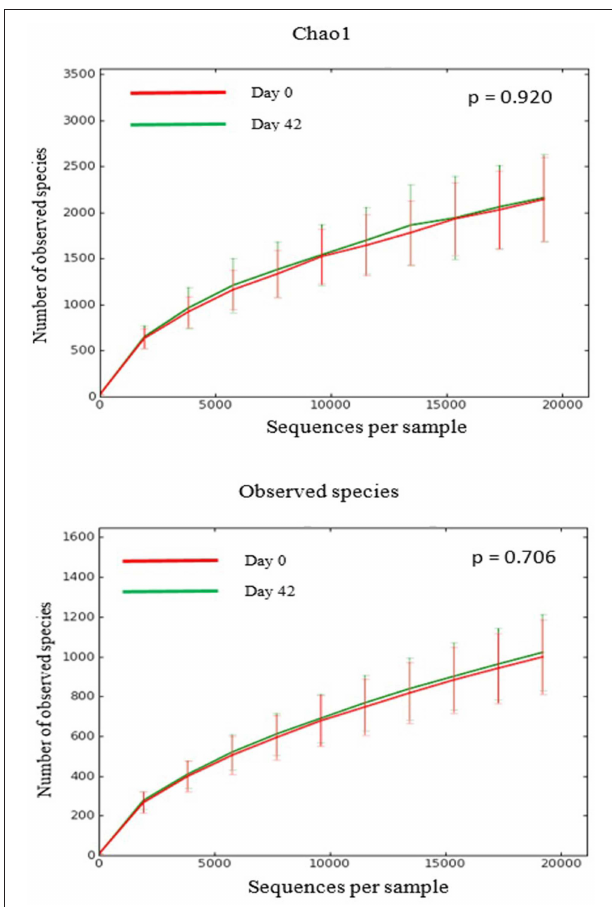
FIGURE 5 | Rarefaction plots of fecal bacterial species from healthy dogs. Data shown are from before (red lines) and 6 weeks after (green lines) a change to a hydrolyzed protein diet as a sole food, and expressed by the Chao1 diversity index (upper panel) and the number of observed bacterial species (lower panel).